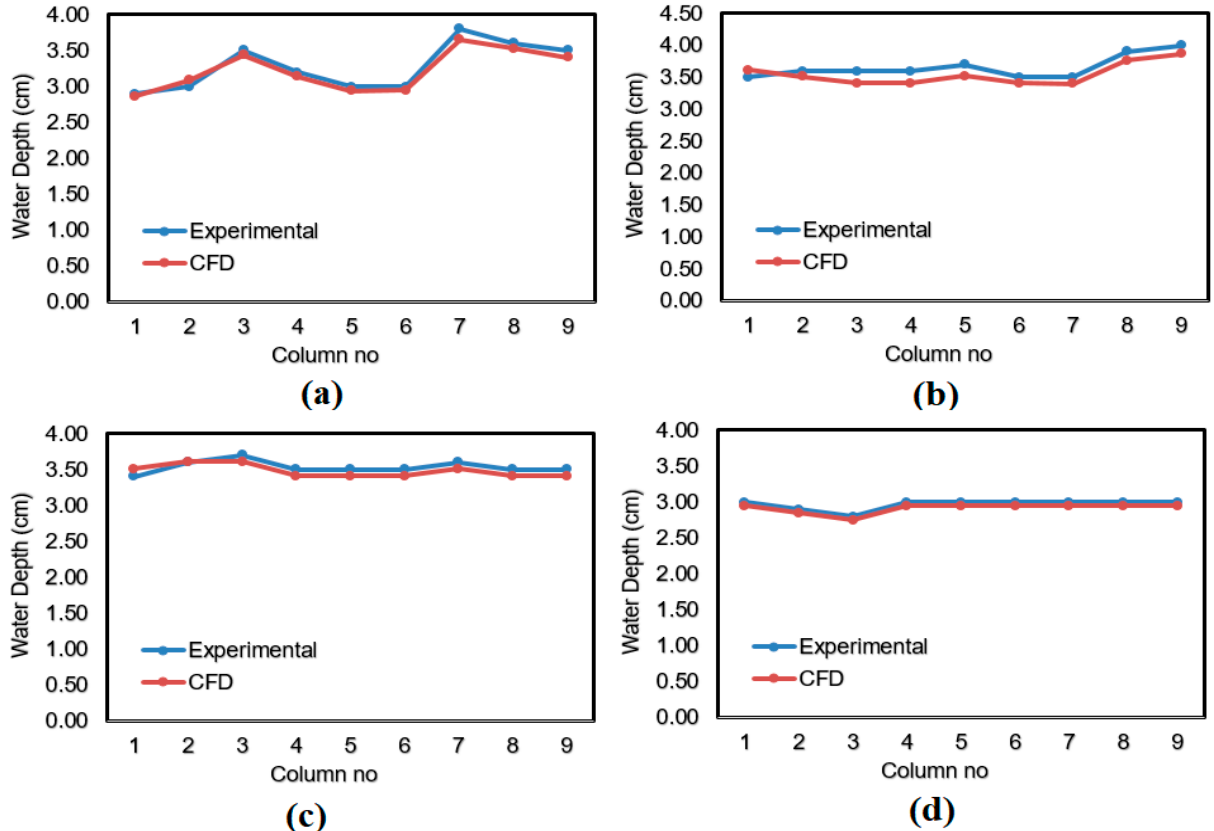
Figure 20. CFD and experiment results for water depths: ( a ) Cross-section 1; ( b ) Cross-section 2; ( c ) Cross-section 3; ( d ) Cross-section 4.